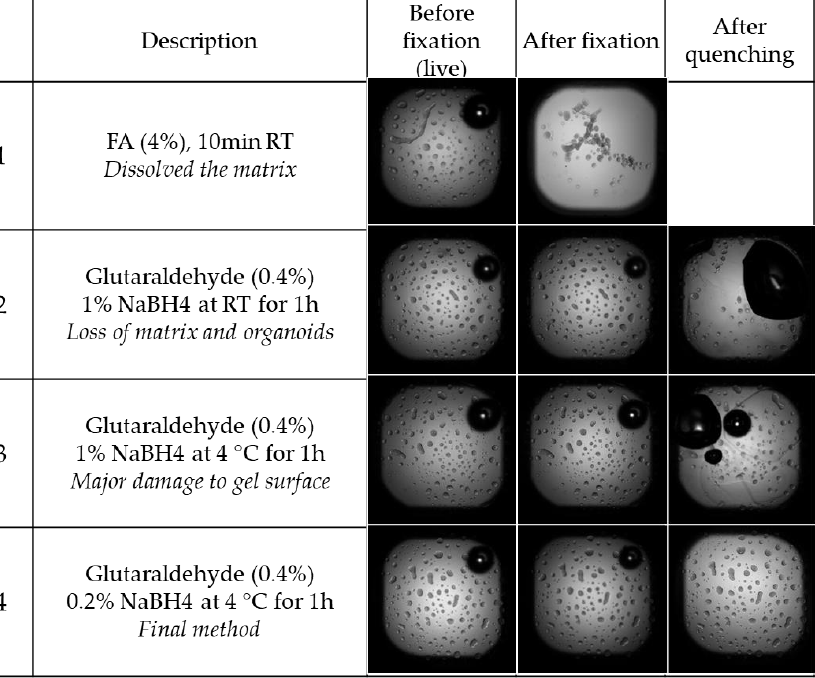
Figure 1. Optimization of fixing and quenching protocols with example Brightfield images at 4×.